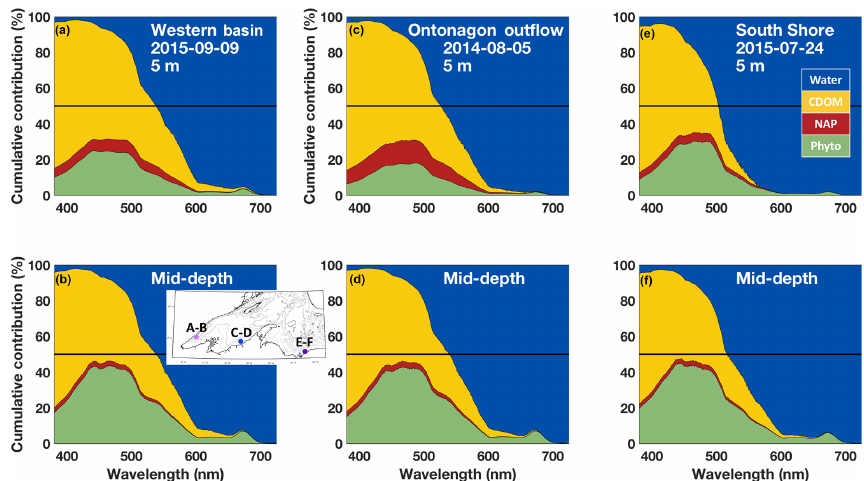
Figure 5. Spectrally resolved contribution of water, CDOM, non-algal particles, and phytoplankton to total absorption for discrete water samples taken at 5m (a, c, e) and at mid-depth (b, d, f) from the western basin ( a, b ; light purple marker on map inset in b ), Ontonagon River outflow ( c, d ; blue marker on map), and the South Shore ( e, f ; dark purple marker on map) of Lake Superior in the summer of 2014–2015. The black lines indicate a 50% cumulative contribution for visual reference.